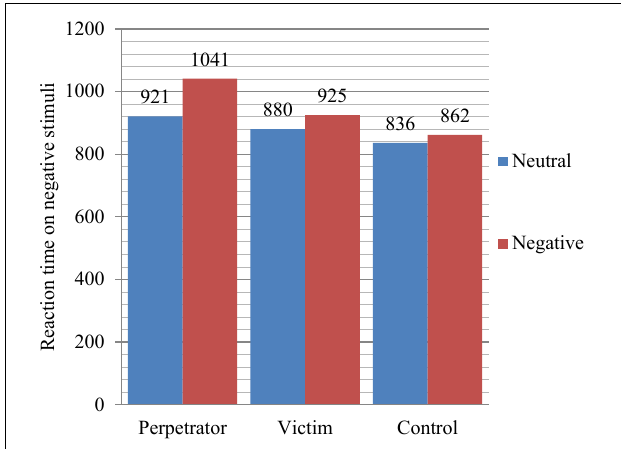
FIGURE 2 | Differences between the groups in terms of correctness of the responses (naming word color) to negative and neutral stimuli (for details see Table 1